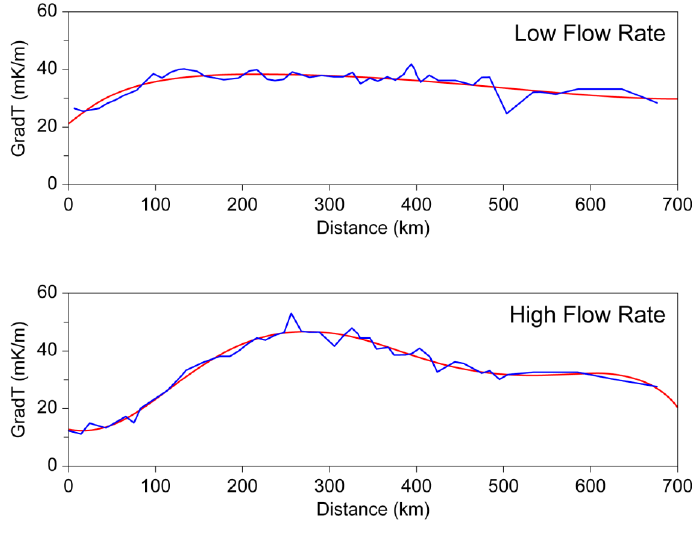
Figure 12. ( a ) Geothermal gradient across the WCSB profile from numerical modeling [10] for a base heat flow of 70 mW/m 2 , a thermal conductivity model of the sedimentary cover and a surface temperature constrained by 0 °C for two scenarios of gravity driven regional fluid flow (upper panel-velocity of 10 − 2 m/year and lower panel-10 2 m/year. The surface temperature of 0 °C was chosen because the thermal field in the deeper sediments is still in equilibrium with this temperature [4]. The red curve shows the smoothed thermal gradient; ( b ) Assumed flow paths (modified from